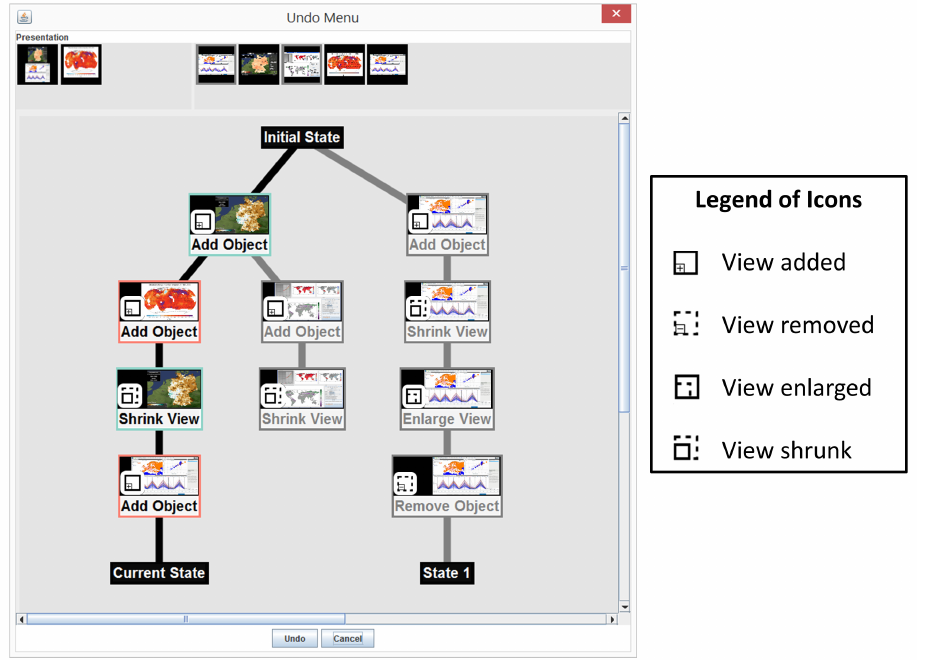
Screenshot of the undo interface. The main view in the middle shows a visualization of a branching interaction history. Participants can use this history to switch to previous views by double clicking on an item of a branching path. The individual displays of the multi-display environment are depicted in the upper left corner by icons showing the currently displayed views. All previously used views are displayed at the upper right part of the undo interface. Participants can select displays or views to apply regional and/or object-based filters to the